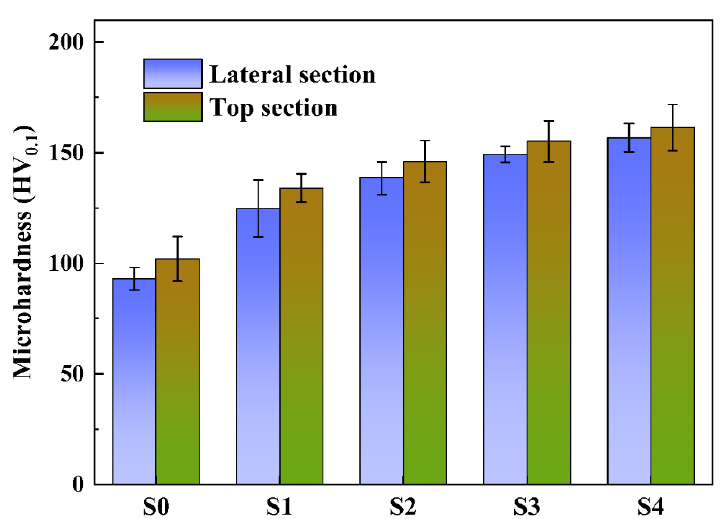
Figure 4. Microhardness histograms of as-printed S0-S4 samples in the lateral and top sections.